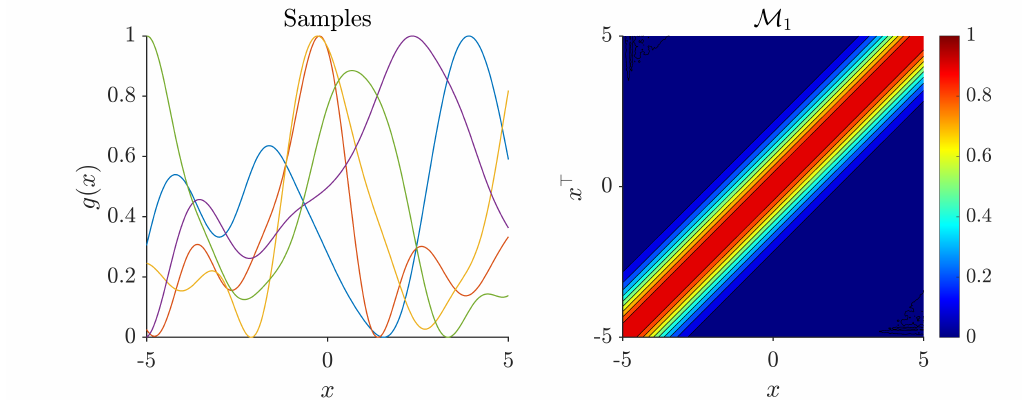
Figure 2. A pictorial representation of Equation (5). Left panel : five samples drawn at random from the GP marked with five colors, built using Equation (5), captures the smooth and locally correlated nature of the GP . Right panel : a contour plot depicting correlations between outputs of one-dimensional vectors x , x (cid:48) ∈ X . Color code represents the covariance k ( x , x (cid:48) ) with red representing high covariance i.e., output values g ( x ) , g ( x (cid:48) ) are highly correlated and